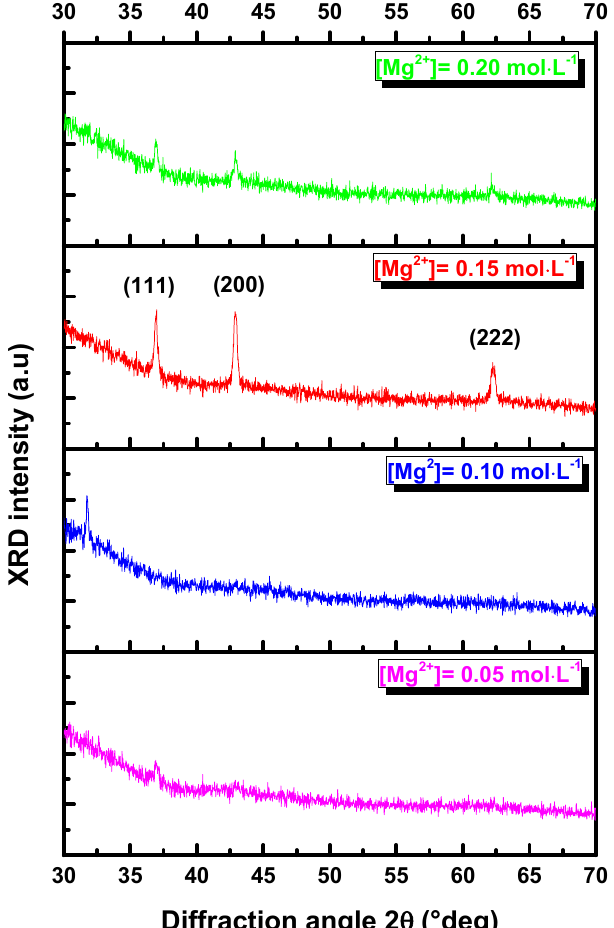
Figure 1. X-ray spectra of MgO thin films deposited on glass substrates for different concentrations ([Mg 2+ ] = 0.05; 0.10; 0.15 and 0.20 mol·L − 1 ).